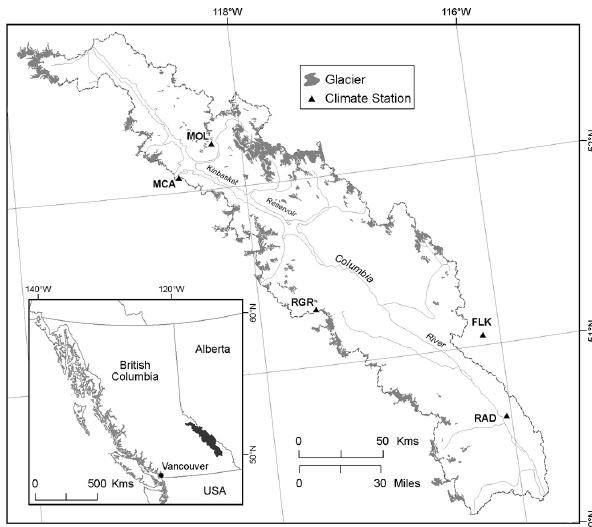
Fig. 1. Location of the Mica basin and locations of climate stations used to force the hydrological